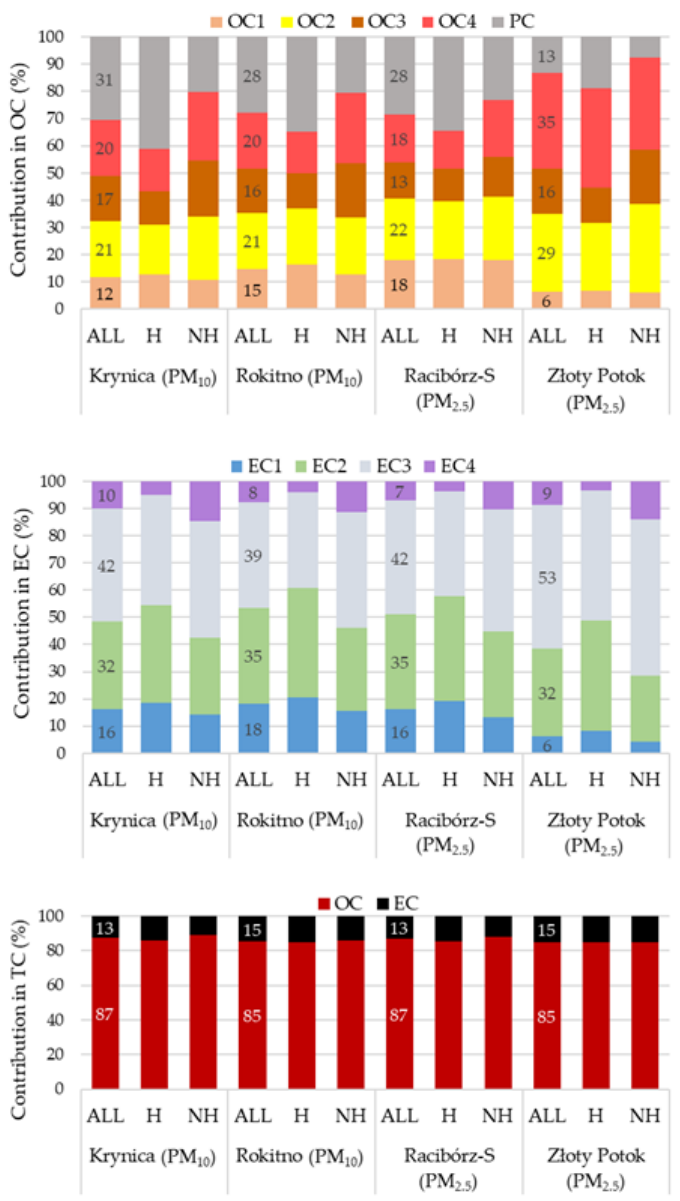
Figure 8. Profiles of nine temperature fractions against the share of OC and EC in total TC at the considered rural background sites.